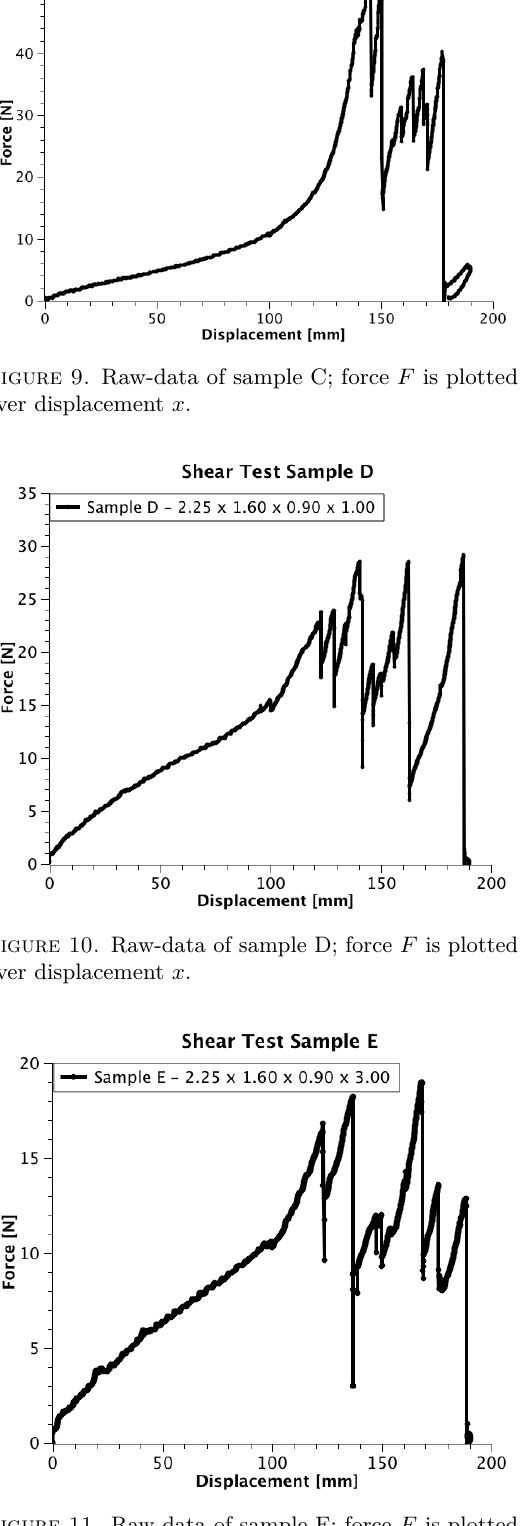
Figure 11. Raw-data of sample E; force F is plotted over displacement x .